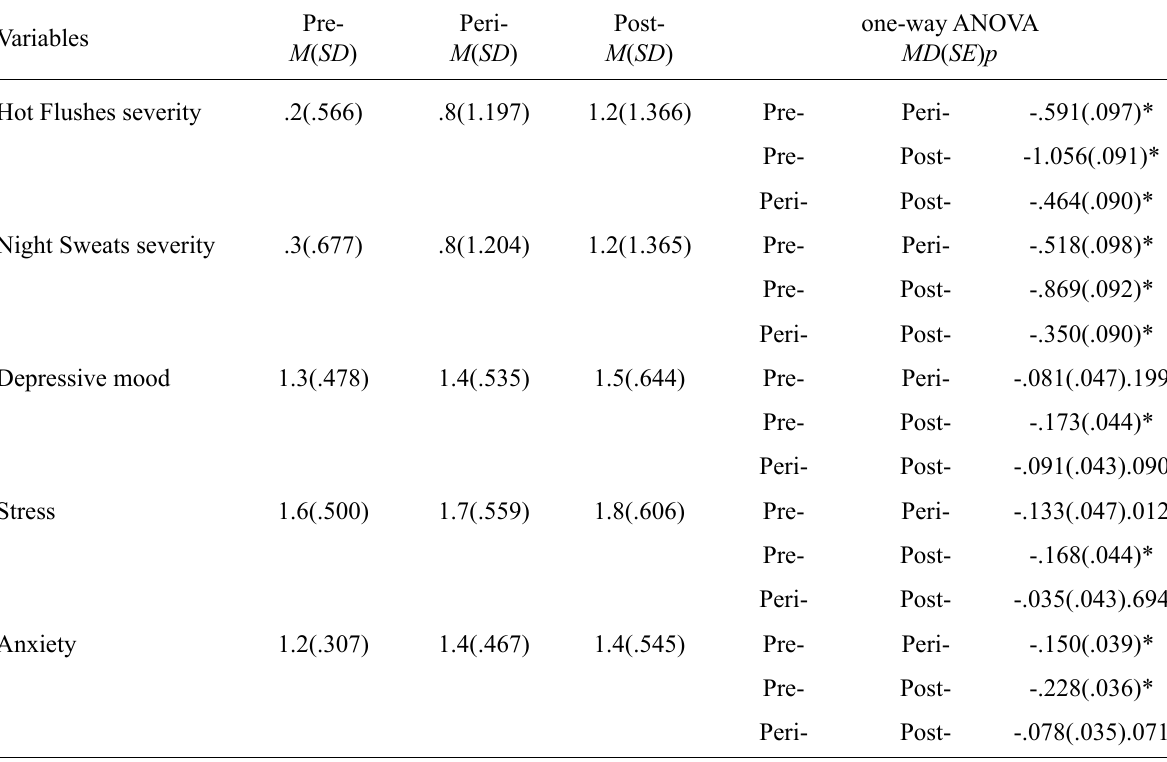
Table 3 Mean Scores for Vasomotor and Psychological Variables and Differences between the Three Menopausal Statuses Variables